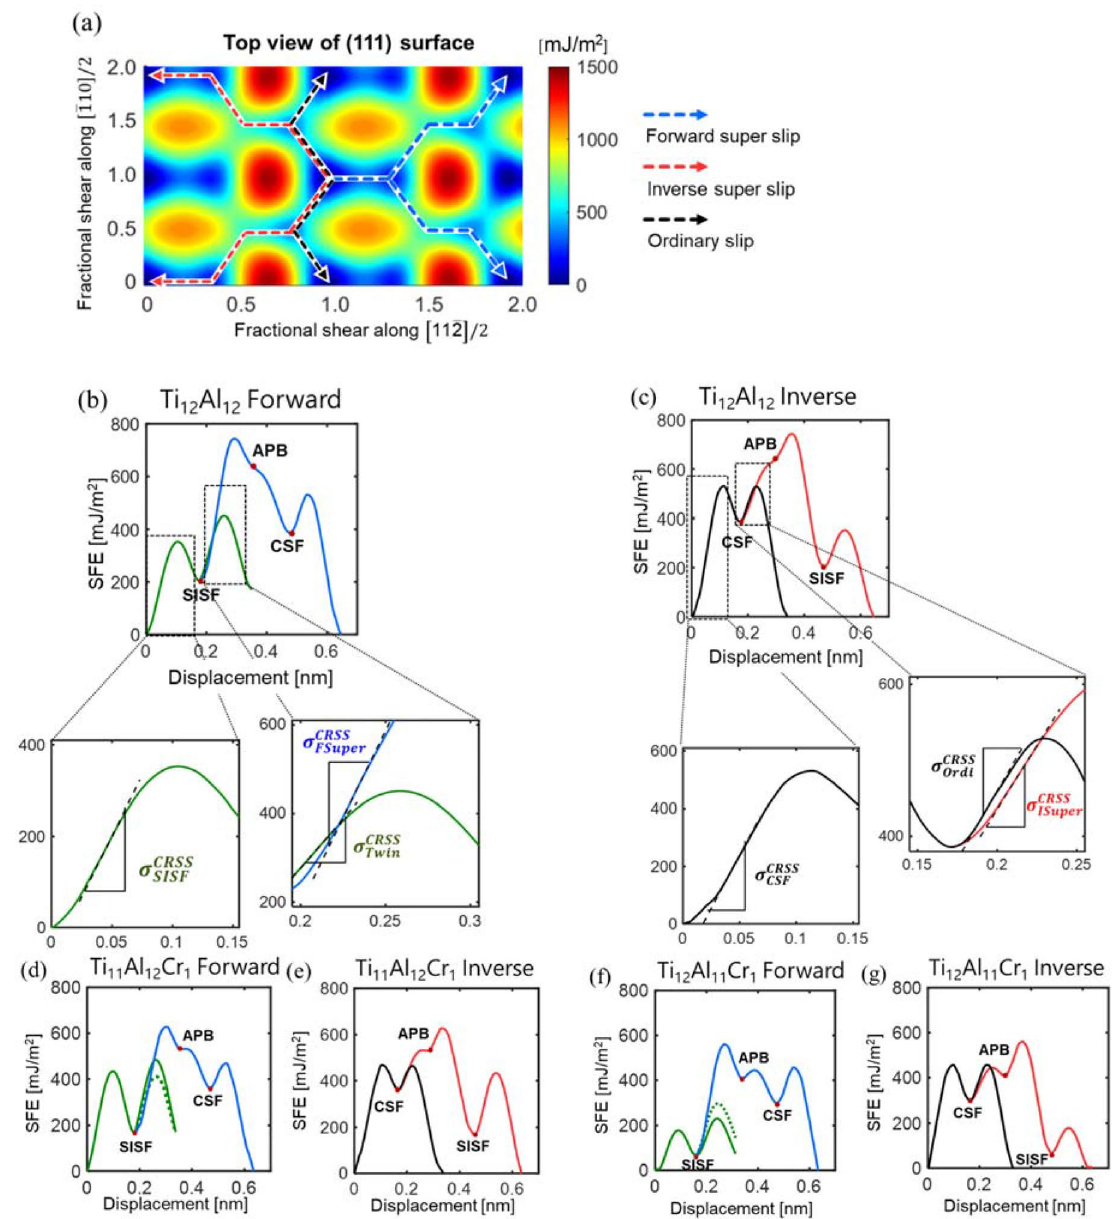
Figure 6. (a) GSFE surface of stoichiometric gamma TiAl (Ti 12 Al 12 ). GSFE curves for (b) forward super slip and twinning (the maximum slope of the GSFE curve is the critical resolved shear stress) and (c) inverse super slip and ordinary slip in stoichiometric gamma TiAl. GSFE curves for (d) forward super slip and twinning, (e) inverse super slip and ordinary slip, (f) forward super slip and twinning, and (g) inverse super slip and ordinary slip in Ti 12 Al 11 Cr 1 (the blue line is forward super slip, the red line is inverse super slip, the black line is ordinary slip, and the green line is